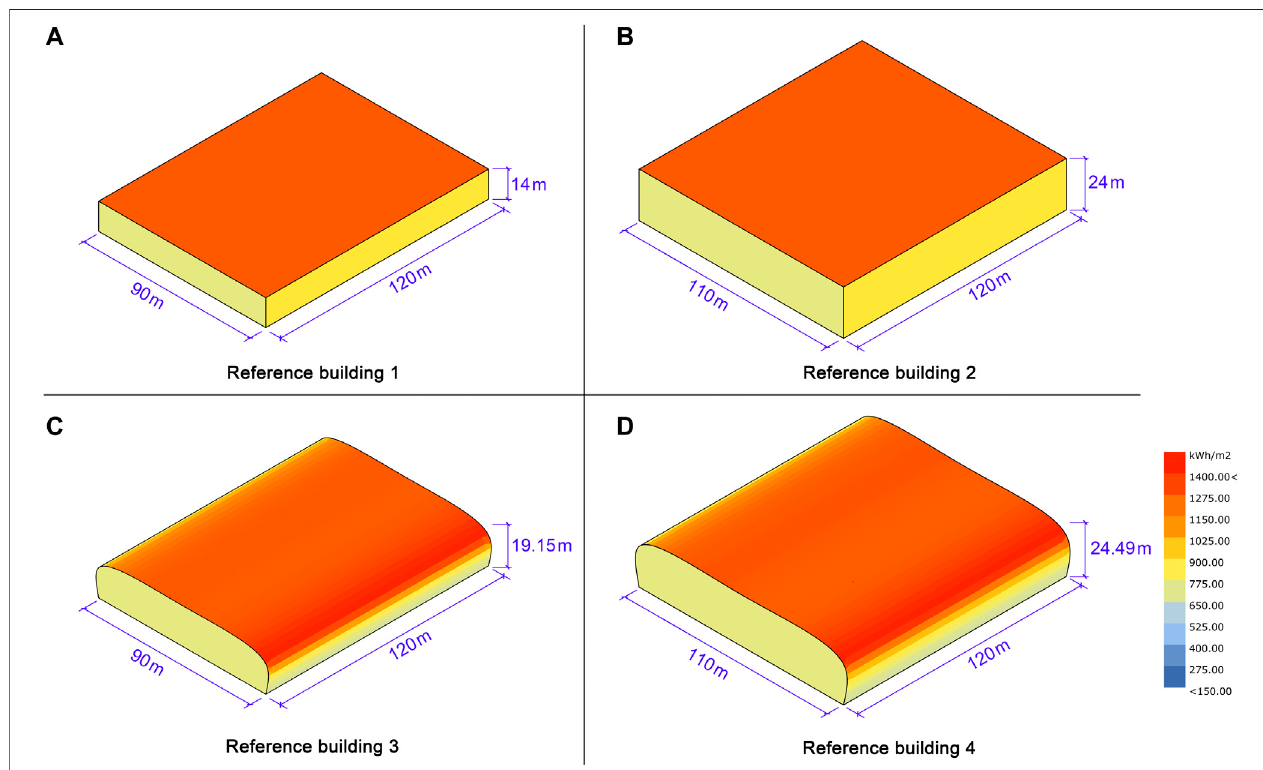
FIGURE10| Theshapesandsolarradiationdistributionsofthereferencebuildings: (A) Referencebuilding1; (B) Referencebuilding2; (C) Referencebuilding3; (D) Reference building 4.